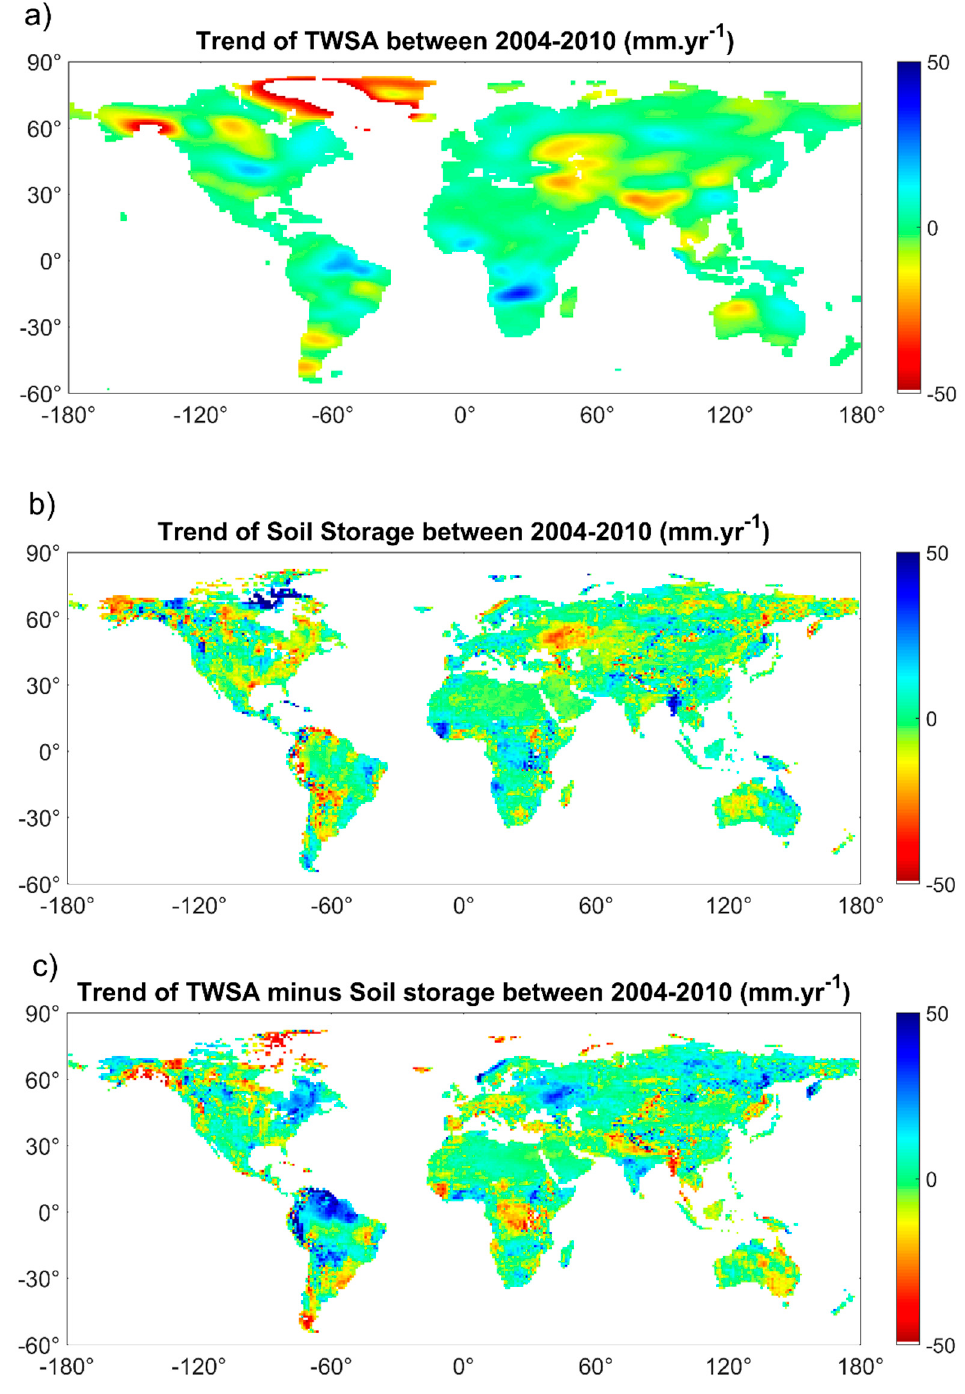
Figure 3. Terrestrial trends estimated over 2004–2010 from ( a ) Gravity Recovery and Climate Experiment (GRACE)-based Terrestrial Water Storage (TWS) anomalies (GFZ RL05 GRACE solutions preprocessed using the destriping technique from [90] and smoothed at 300 km of radius) corrected from GIA from [46], ( b ) soil moisture (SM) and snow from Global Land Data Assimilation System (GLDAS)-NOAH 2.7.1 [52] and ( c ) difference between TWS from GRACE corrected from GIA and SM and snow for the whole land surfaces. These datasets were made available by [91].